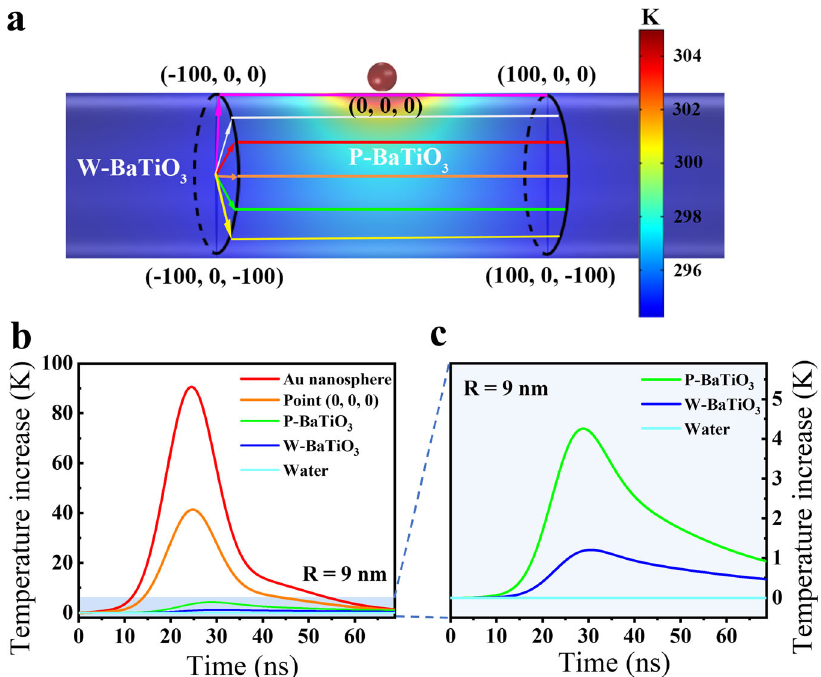
Fig.4|Thermalsimulation.a Temperaturedistributionofthestructuralmodelof aAuNP (9nminradius)suspending overaBaTiO 3 cylinderwithlengthof1 µ mand radius of 50nm at the moment with highest temperature inside Au NP. b Time evolution of the temperature of point (0, 0, 0) and the average temperature of Au